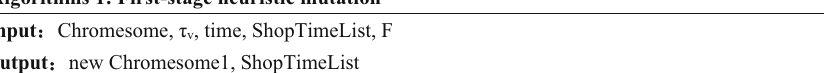
Algorithms 1: First-stage heuristic